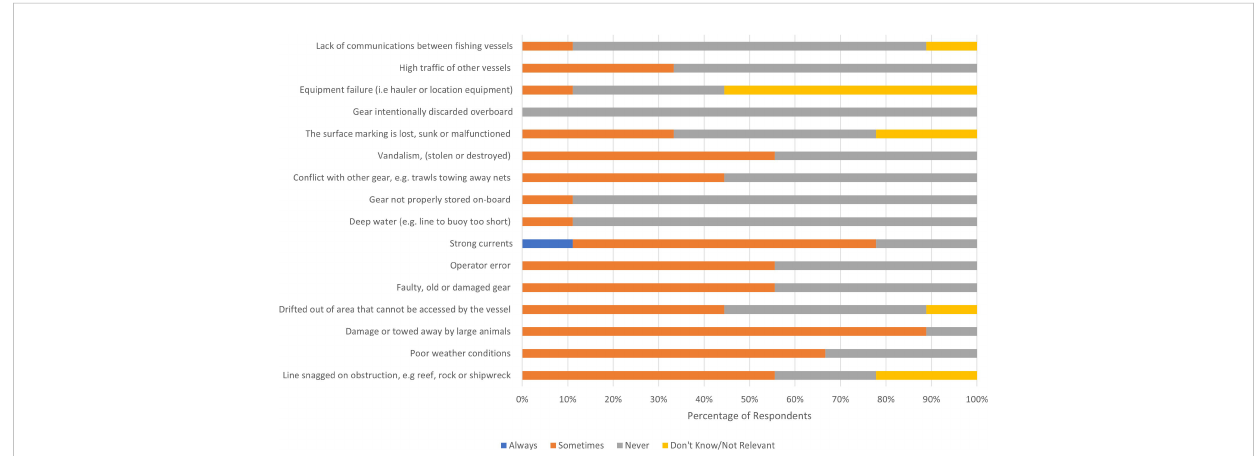
FIGURE 2 Summary of interview results from Antigua and Barbuda to the question: “ When a vessel loses hooks or lines, what are the main causes of the gear loss and corresponding frequency of occurrence? ” (n =